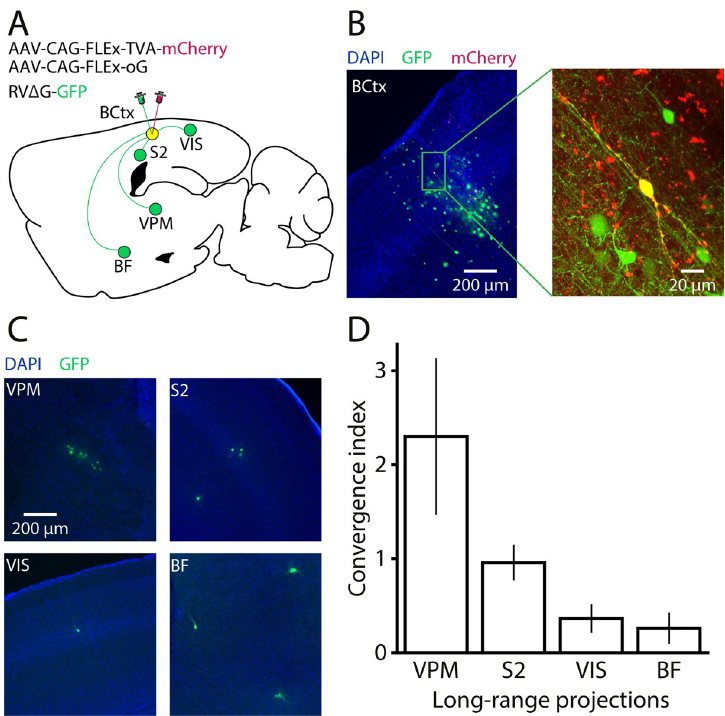
Fig 4. Rabies trans -synaptic tracing from VChIs in the barrel cortex. (A) Illustration of the experimental procedure and the distal areas innervating the VChIs in the BCtx. The identified presynaptic distal areas of the VChIs are the VPM, S2, VIS, and the BF. (B) An example image of a VChI starter cell (expressing both mCherry and GFP) located in layer 2/3. Inset: zoom-in image showing the bipolar morphology of the cell. (C) Examples of input cells (expressing GFP) from the 4 identified distal areas. (D) The CI distribution quantifying the relative number of input cells per starter cell in all identified input areas. BCtx, barrel cortex; BF, basal forebrain; ChAT, choline acetyltransferase; CI, convergence index; GFP, green fluorescent protein; RV Δ G, G-deleted rabies virus; S2, secondary somatosensory cortex; VChI, VIP/ChAT interneuron; VIP, vasoactive intestinal polypeptide; VIS, primary and secondary visual areas; VPM, ventral posteromedial thalamic